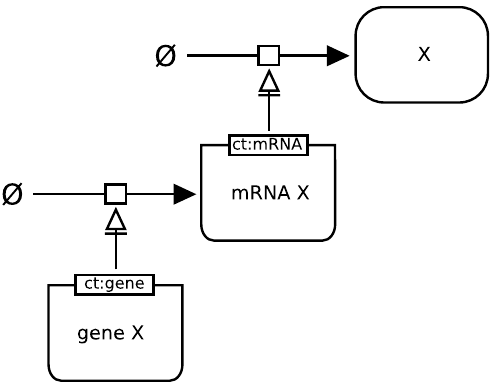
Figure 2.50: The creation of a messenger RNA X triggered by the gene X.